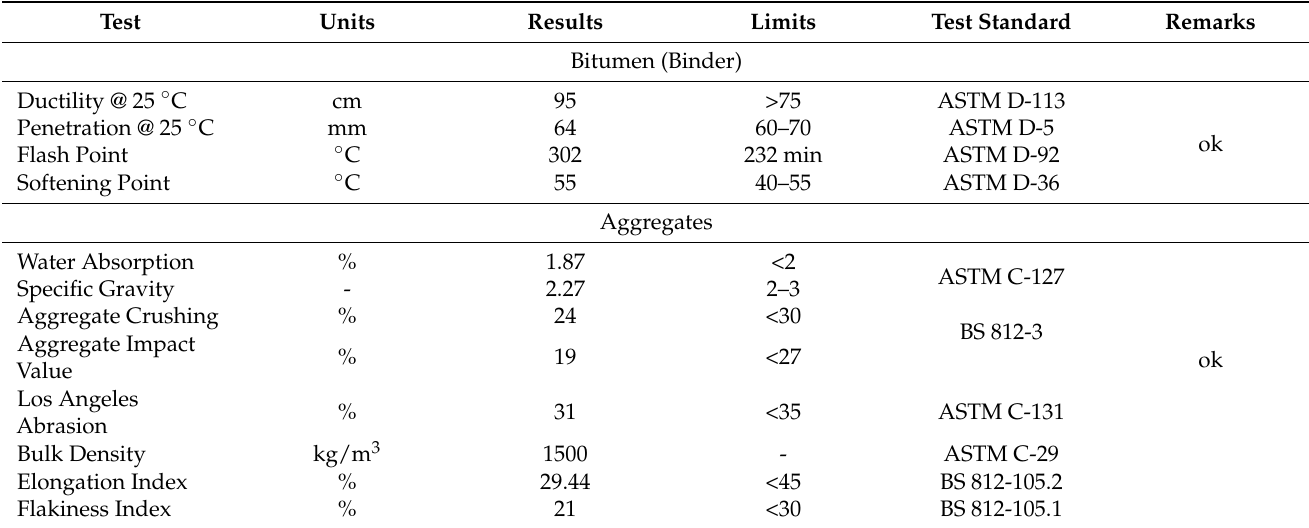
Table 1. Physical properties of polymer-modified